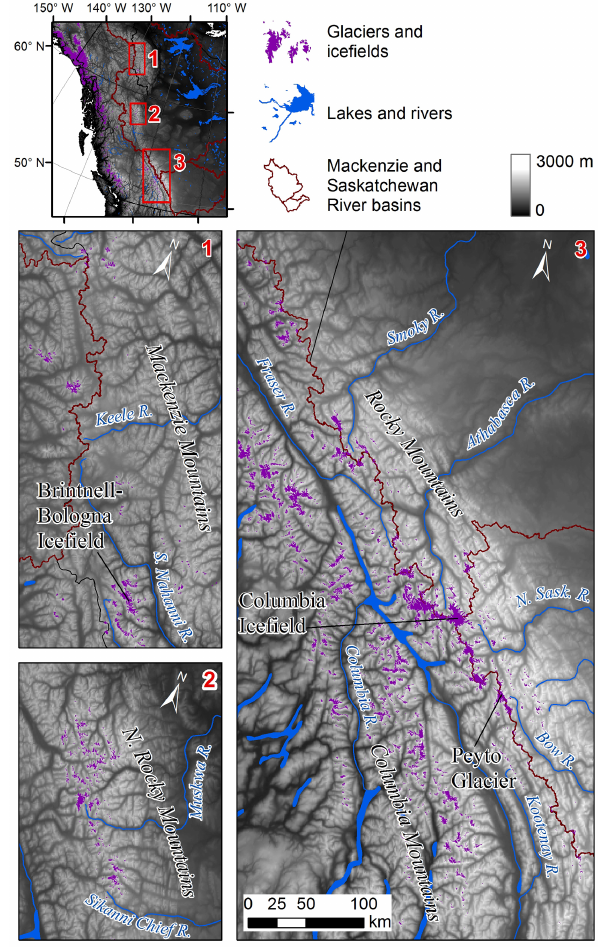
Figure 7. Map of western Canada showing the distribution of glaciers and ice fields within the major interior mountain ranges; the locations CCRN glacier observatories are indicated. Glacier ex- tents are from the GLIMS database (www.glims.org/) and the North American Environmental Atlas (http://www.cec.org/sites/default/ atlas/map/).